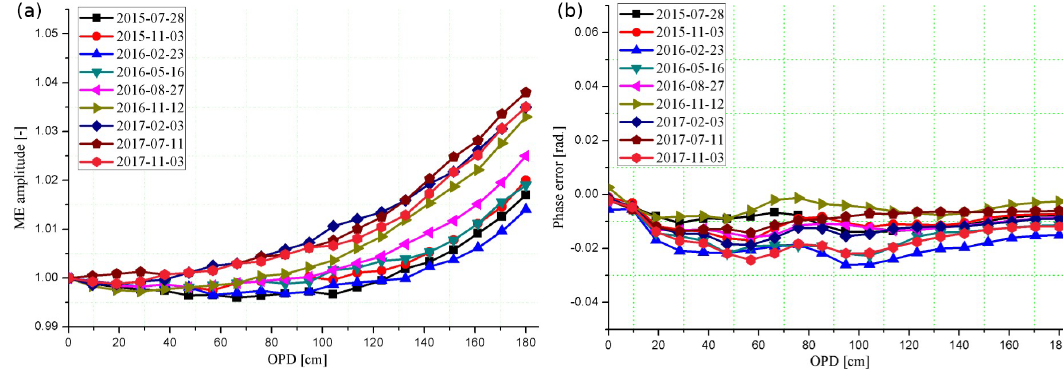
Figure 5. ME amplitudes (a) and phase errors (b) along with the OPD deduced from HBr cell measurements at